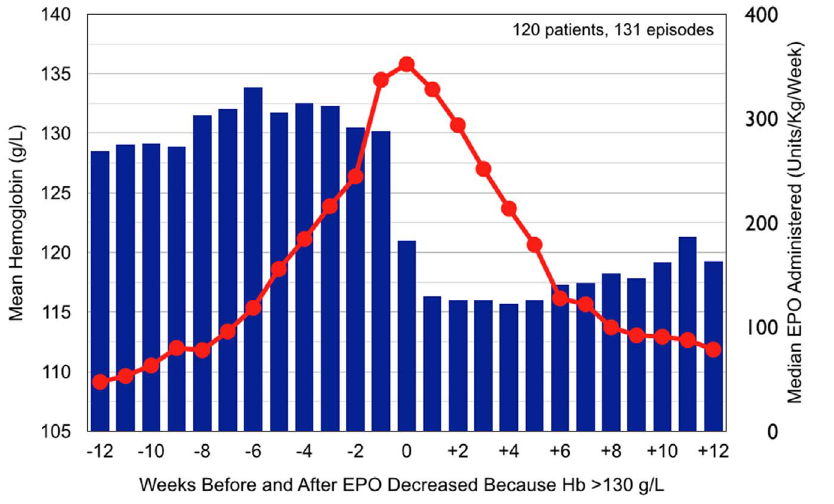
Figure 2. Summary of findings for 12 weeks before and after EPO administration was decreased because Hb was . 130 g/L in 120 patients (131 episodes) in the study dialysis unit during the protocol period in calendar year 2009. EPO reduction (blue bars) was followed by pronounced and prolonged reduction of Hb (red dots) to , 115 g/L. Similar observations were made in 2 other dialysis units that deployed the EMR.